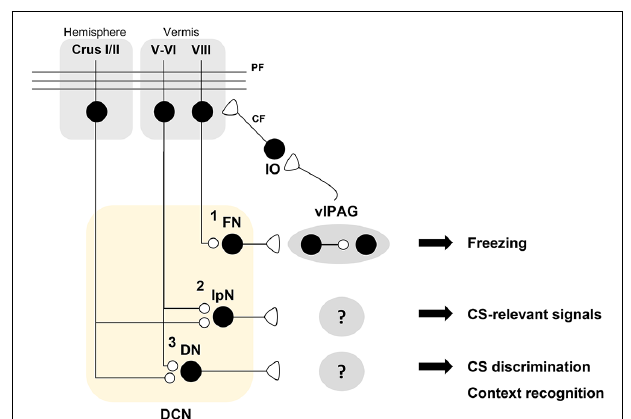
FIGURE 3 | A hypothetical model for distinct roles of deep cerebellar nuclei (DCN) sub-nuclei in fear conditioning. A schematic illustration of the hypothesis that DCN sub-nuclei including the fastigial nuclei (FN), interpositus nuclei (IpN), and dentate nuclei (DN) play distinct roles in fear processing. (1) The FN innervates dopaminergic interneurons which regulate the freezing-regulating ChX10 + neurons in a D2R-dependent manner in the ventrolateral periaqueductal gray (vlPAG; Vaaga et al., 2020). Bi-directional modulation of the FN-vlPAG circuit positively regulates conditioned stimulus (CS)-dependent fear extinction learning (Frontera et al., 2020). vlPAG stimulation evokes inferior olive (IO)-mediated synaptic inputs to pyramidal cells (PCs) in lobule VIII (Koutsikou et al., 2014). Cholera toxin b (CTb)-saporin treatment in lobule VIII abolishes both vlPAG activation-induced facilitation of the H-reflex and freezing behavior in response to an innate fear-evoking stimulus and a CS (Koutsikou et al., 2014). (2) The IpN is necessary for the consolidation of auditory fear memory (Sacchetti et al., 2002). It is hypothesized that the IpN receives PC inputs from lobule V-VI or other hemispheric regions for encoding CS-related signals. (3) The DN may contribute to CS discrimination as well as contextual recognition for fear learning and memory. Crus I/II, which are required for contextual fear memory, are thought to contribute to fear memory processing in the